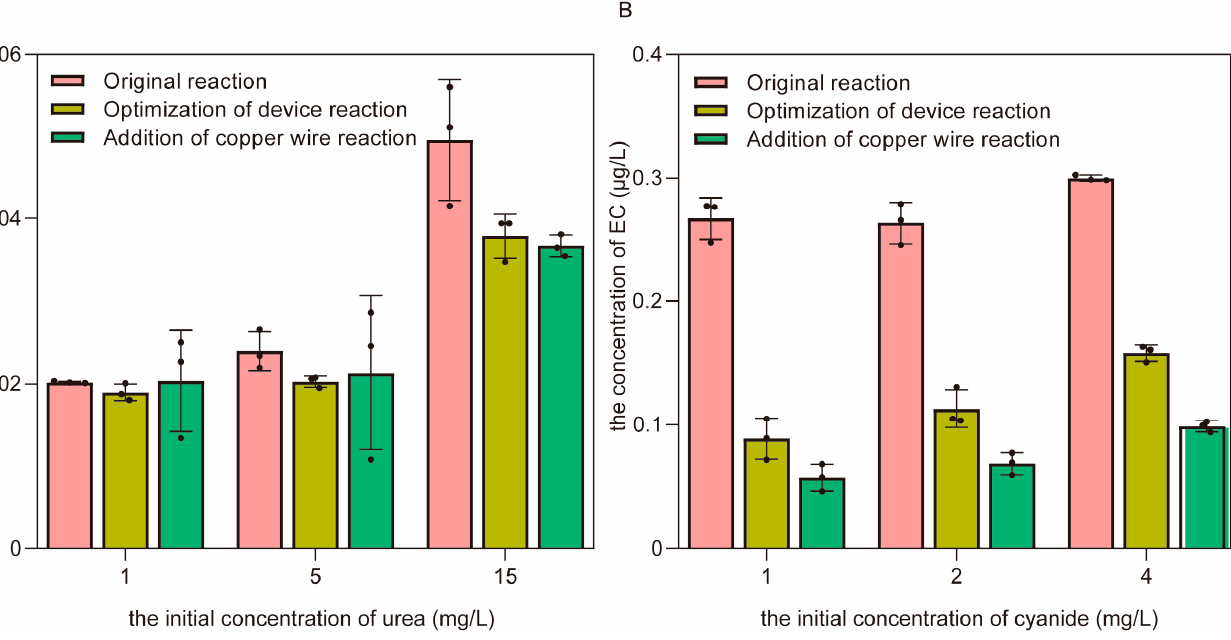
Figure 8. The concentration of EC in the distillate after the optimization of the distillation device and the addition of copper wires. ( A ) The effect of control strategies on the formation of EC using urea as a precursor. ( B ) The effect of control strategies on the formation of EC using cyanide as a precursor.